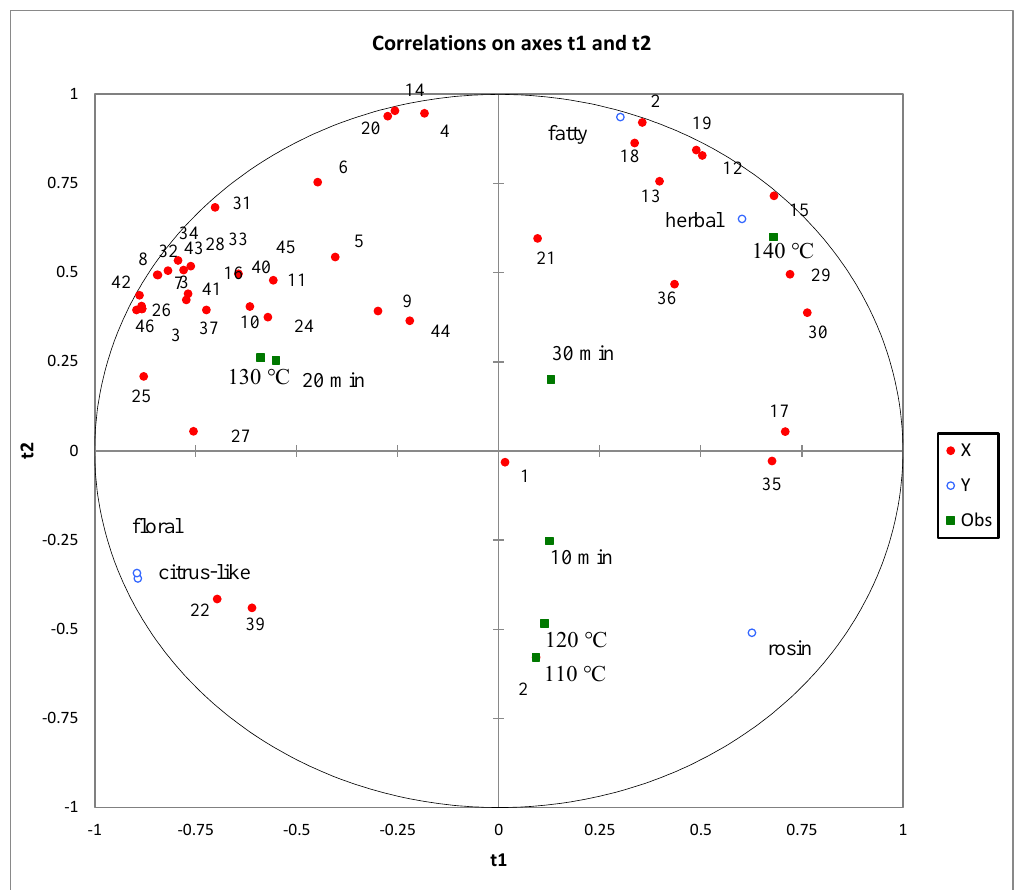
Figure 6. PLSR correlation loading plot of the relationships between 46 volatile compounds (red plots) and sensory attributes.